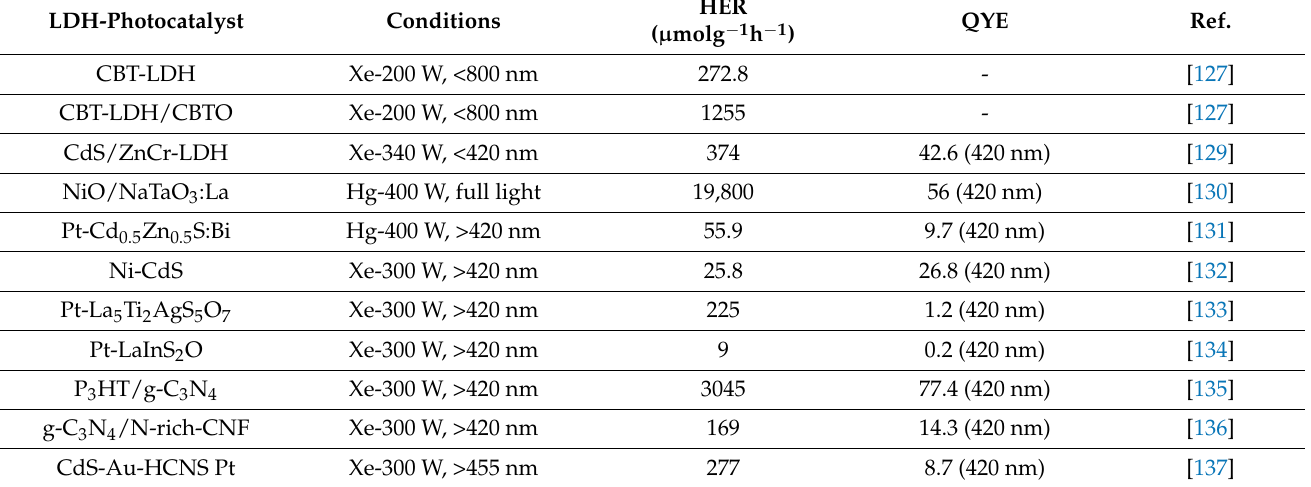
Table 2. Quantum yield efficiencies (QYE) of common photocatalysts and the effectiveness of IR- responsiveness in the solar-to-hydrogen process